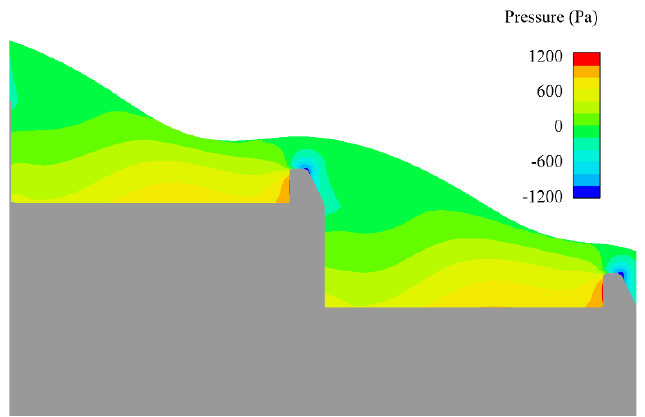
Figure 11. Cloud diagram of the pressure distribution in the type II section at ζ = 0.936.